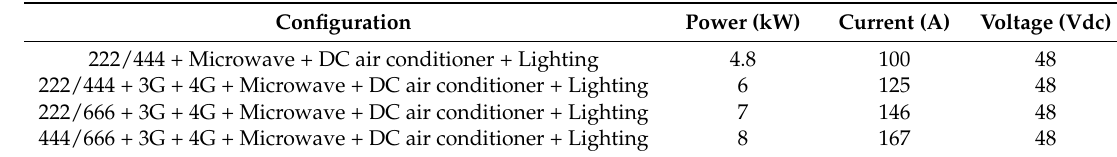
Table 2. Indoor configuration for base